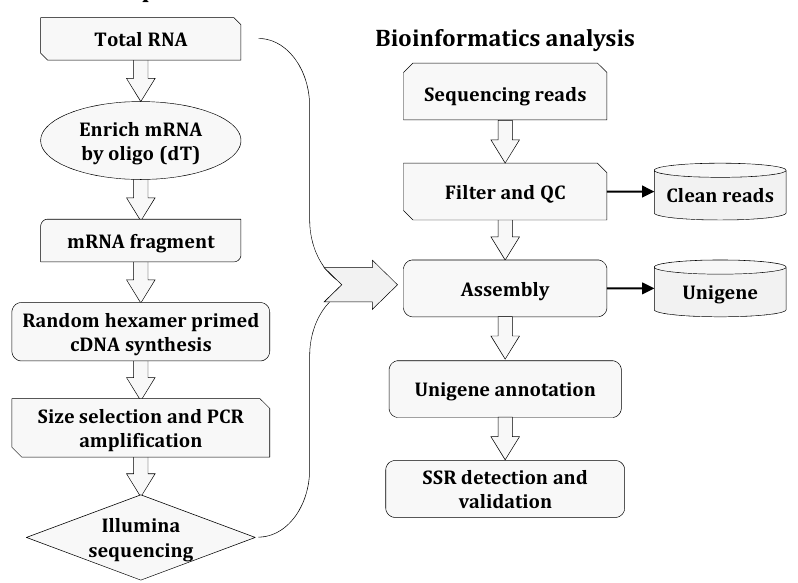
Figure 1. Schematic overview of a de novo transcriptome sequencing and assembly process.